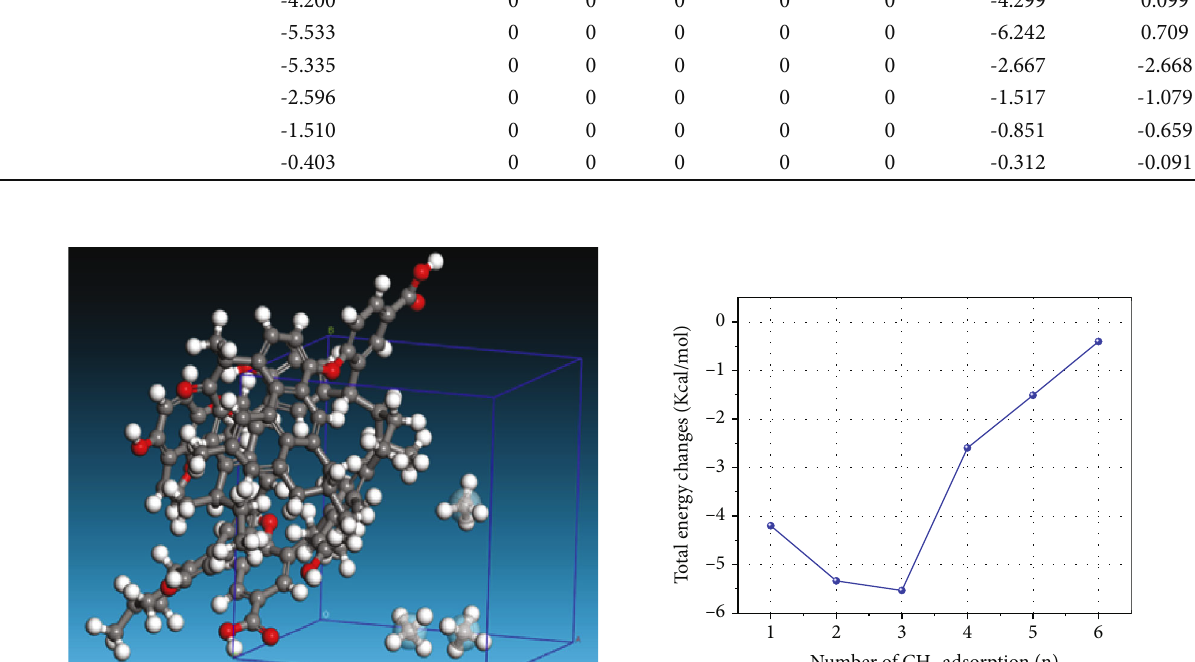
Table 2: Energy changes of the long- fl ame coal molecule before and after adsorption of di ff erent numbers of CH Total energy di ff erence (kcal/mol) Number of CH 4